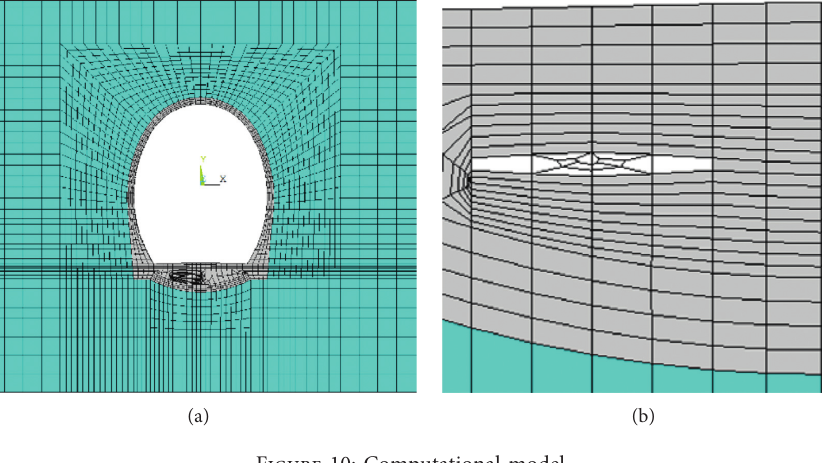
Figure 10: Computational model.